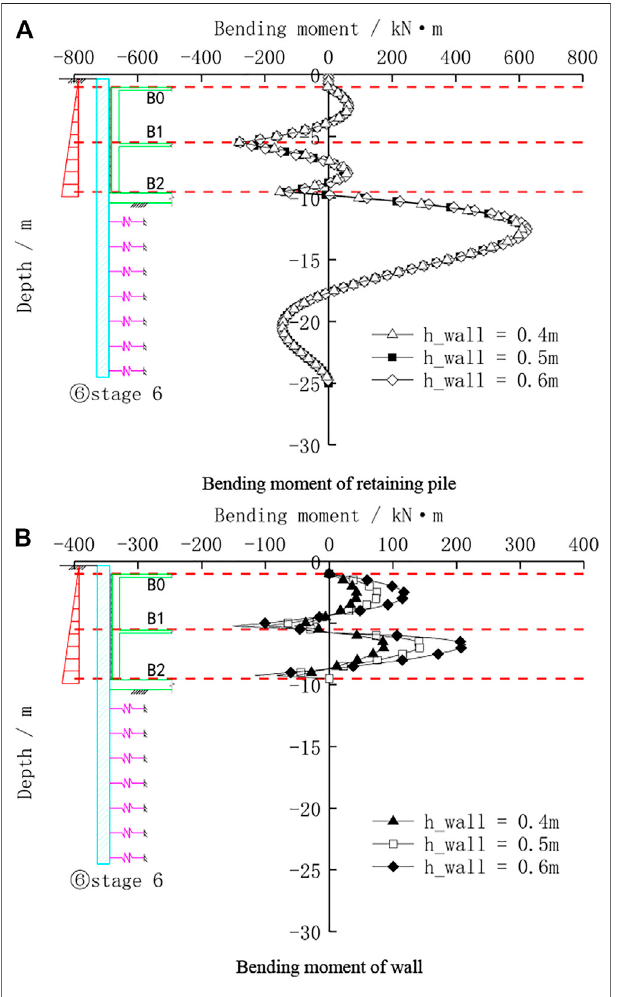
FIGURE 11 | Bending moment of the pile wall combination structure withdifferentstiffnessesofthehorizontalbeamandslab. (A) Bendingmoment of the retaining pile. (B) Bending moment of the